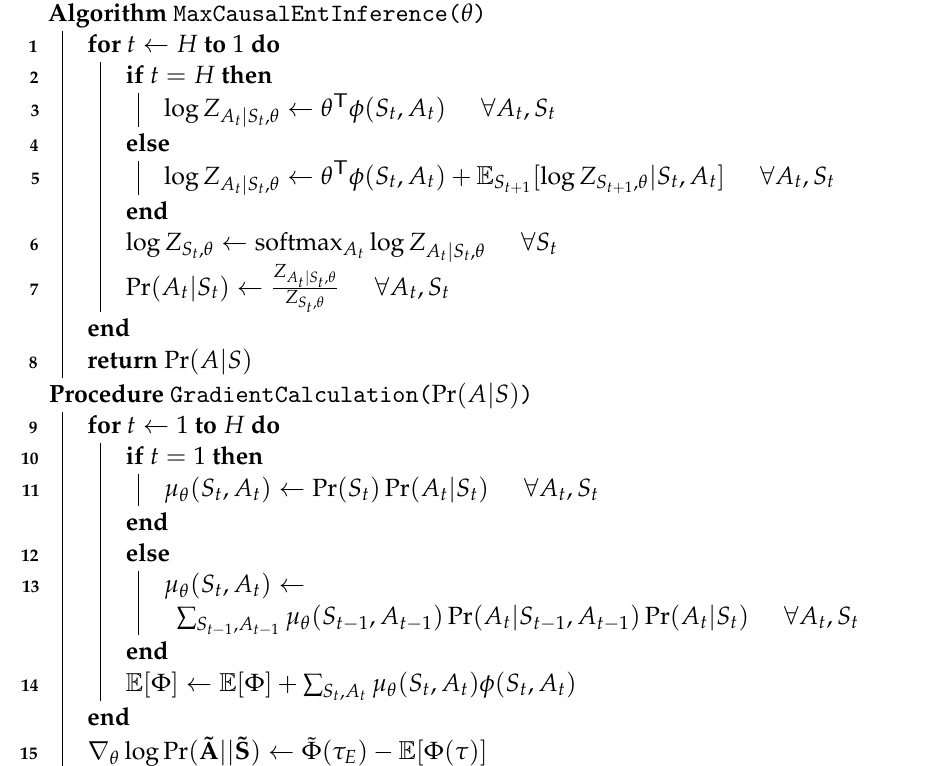
Algorithm 7: Maximum causal entropy algorithm [63,67] Algorithm MaxCausalEntInference( θ